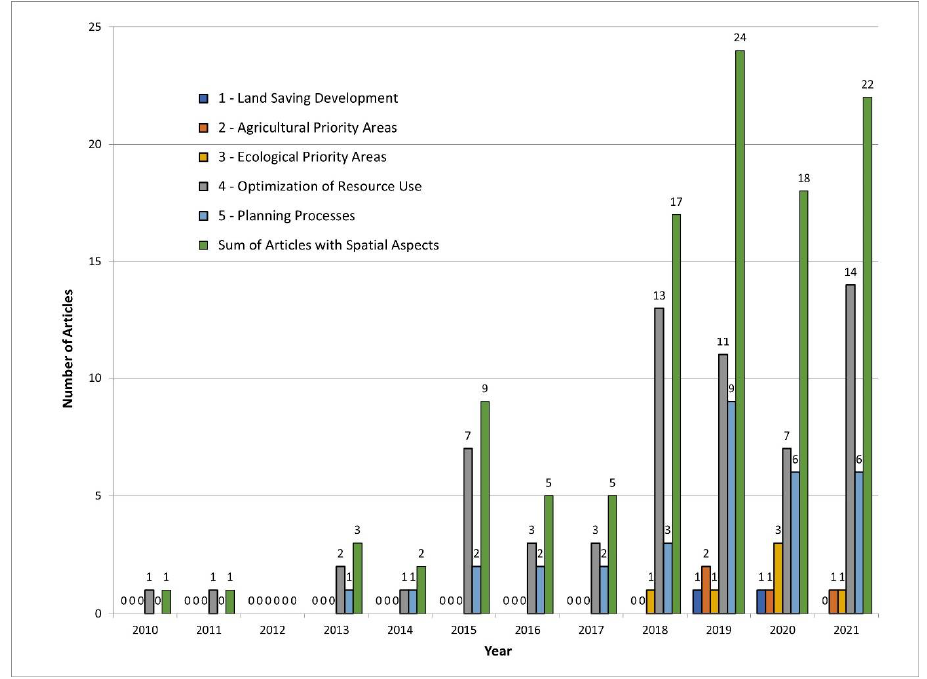
Figure 5. Number of Articles per Year related to the five Core Themes. Table 1. Key topics and main aspects/arguments referring to Core Theme